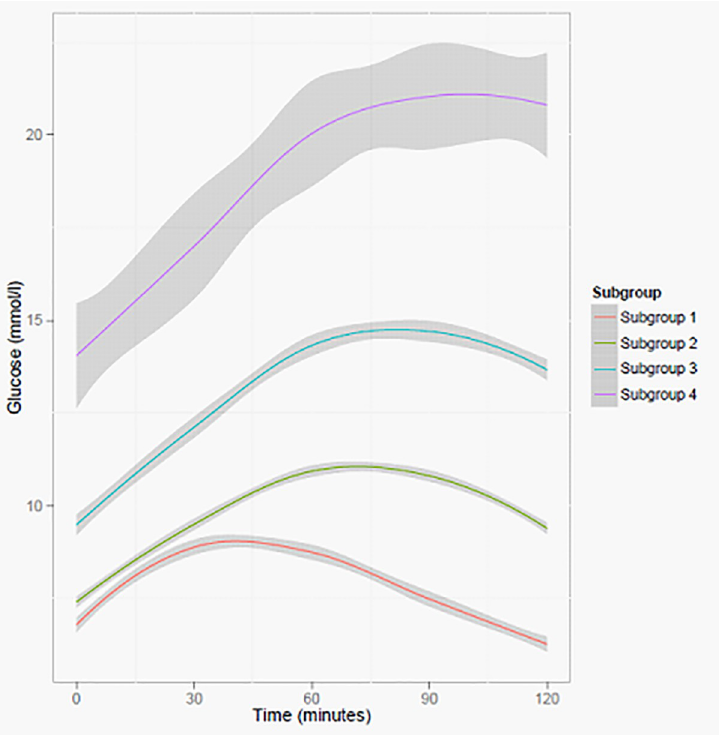
Fig 3. Glucose curve subgroups following a MMT depicting estimated mean trajectories of the 4 group solution identified by the latent class trajectory analysis in 651 individuals with type 2 diabetes at 18 months of follow-up.